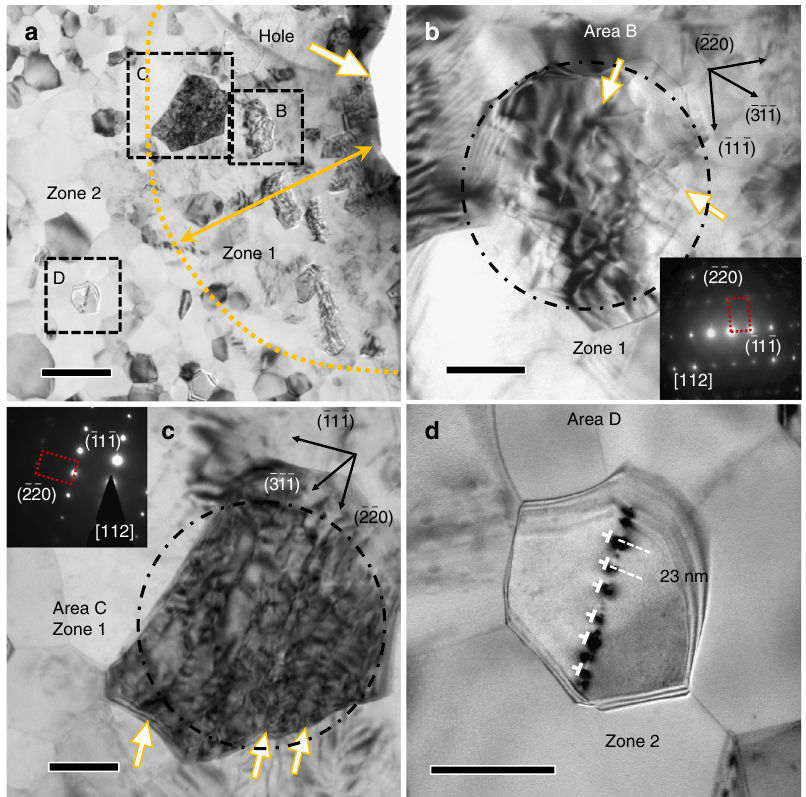
Fig. 5 Dislocation networks after ballistic impact in bright fi eld TEM images. a Low magni fi cation micrograph showing the alteration of the microstructure near a perforated hole in UFG Al. Grains in zone 1 have greater defect density than those in zone 2. Scale bar, 500 nm. b , c Higher magni fi cation views of dislocation networks in areas B and C. The white arrows indicate the traces of dislocations in large grains examined along the < 112 > zone axis. Scale bar, 100 nm. d High magni fi cation image of the area D in zone 2 showing the edge-on view of an array of dislocations aligned along a CTB. A linear array of dislocation cores, separated by ~20 nm, is identi fi ed. Scale bar, 100